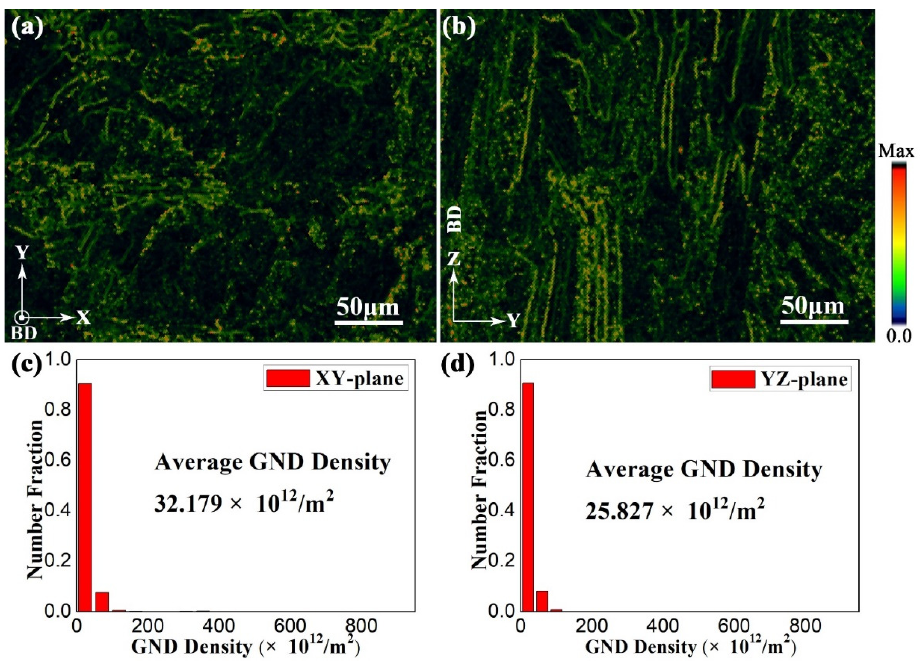
Figure 14. The EBSD maps of geometrically necessary dislocations (GNDs) with the corresponding distribution in sample X at ( a , c ) XY-, and ( b , d ) YZ-planes. distribution in sample X at ( a , c ) XY-, and ( b , d )